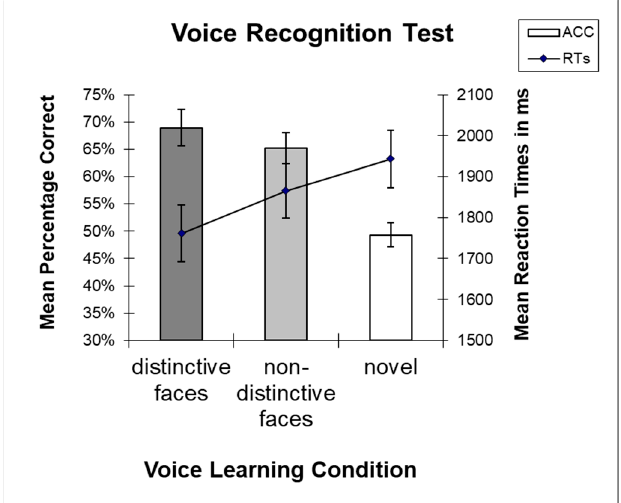
Figure 2. Mean ACCs (bars) and RTs (lines) for learning conditions in the voice recognition test with standard errors of the mean (SEM). Note the faster RTs for voices originally learned with distinctive (vs. non-distinctive) faces.